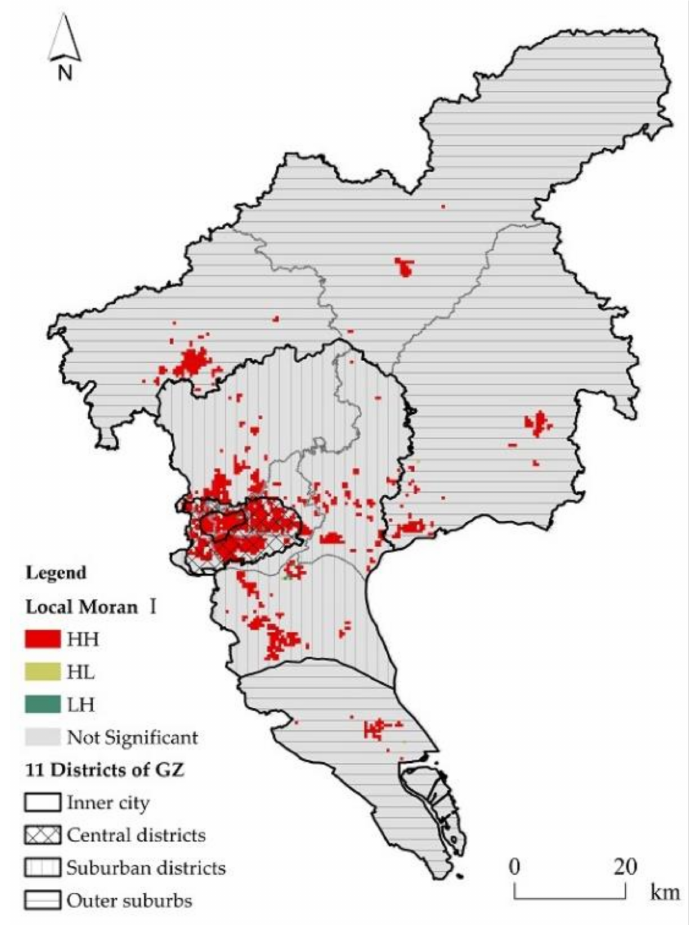
Figure 4. Results of local Moran’s I index of Hive Box distribution in